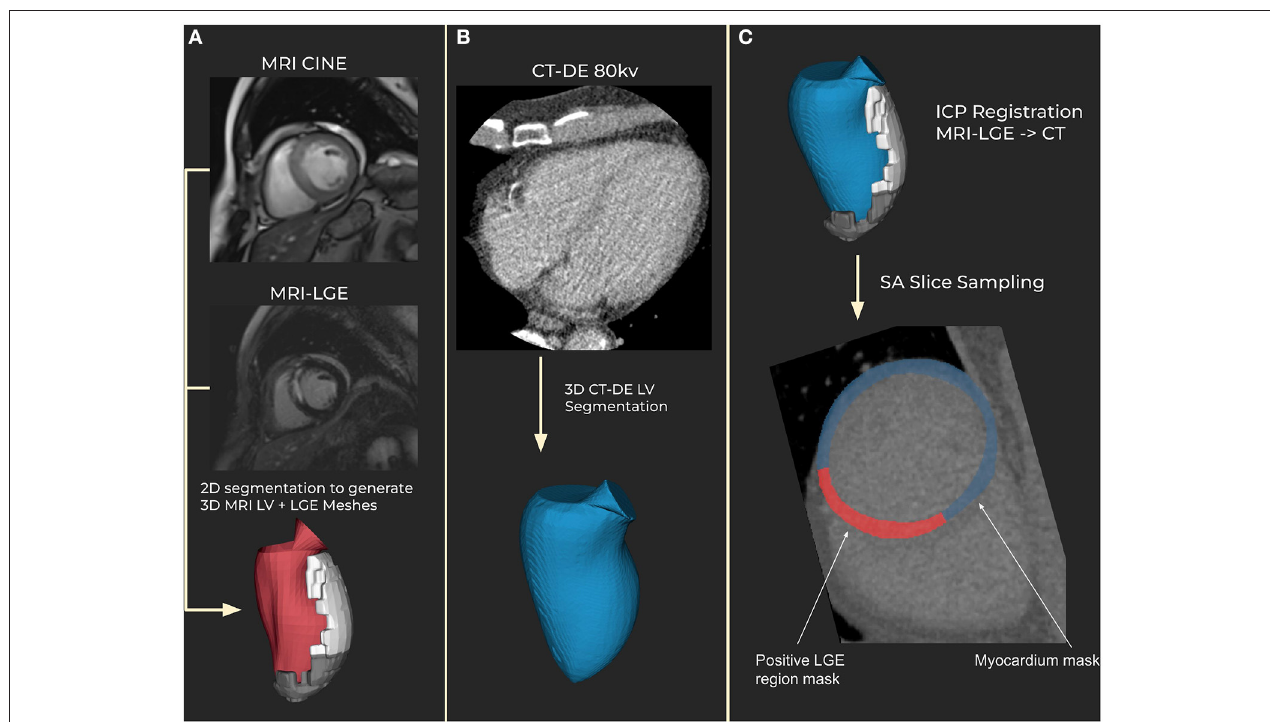
FIGURE 1 | Segmentation and registration. (A) Magnetic resonance imaging (MRI) segmentation using CINE MRI for anatomical 3D mesh and MRI late gadolinium enhancement (LGE) for scar mesh. Endocardial (red) and scar meshes (white) shown (B) Delayed enhancement computed tomography (CT-DE) segmentation to generate a 3D mesh of left ventricle from CT. CT endocardial mesh is shown in blue. (C) CT scar mesh generated by iterative closest point (ICP) registration from the MRI to CT left ventricle anatomical meshes. Applying the resulting transform to the MRI-LGE mesh produces a CT aligned scar mesh. This provides locations to mask for scar on the